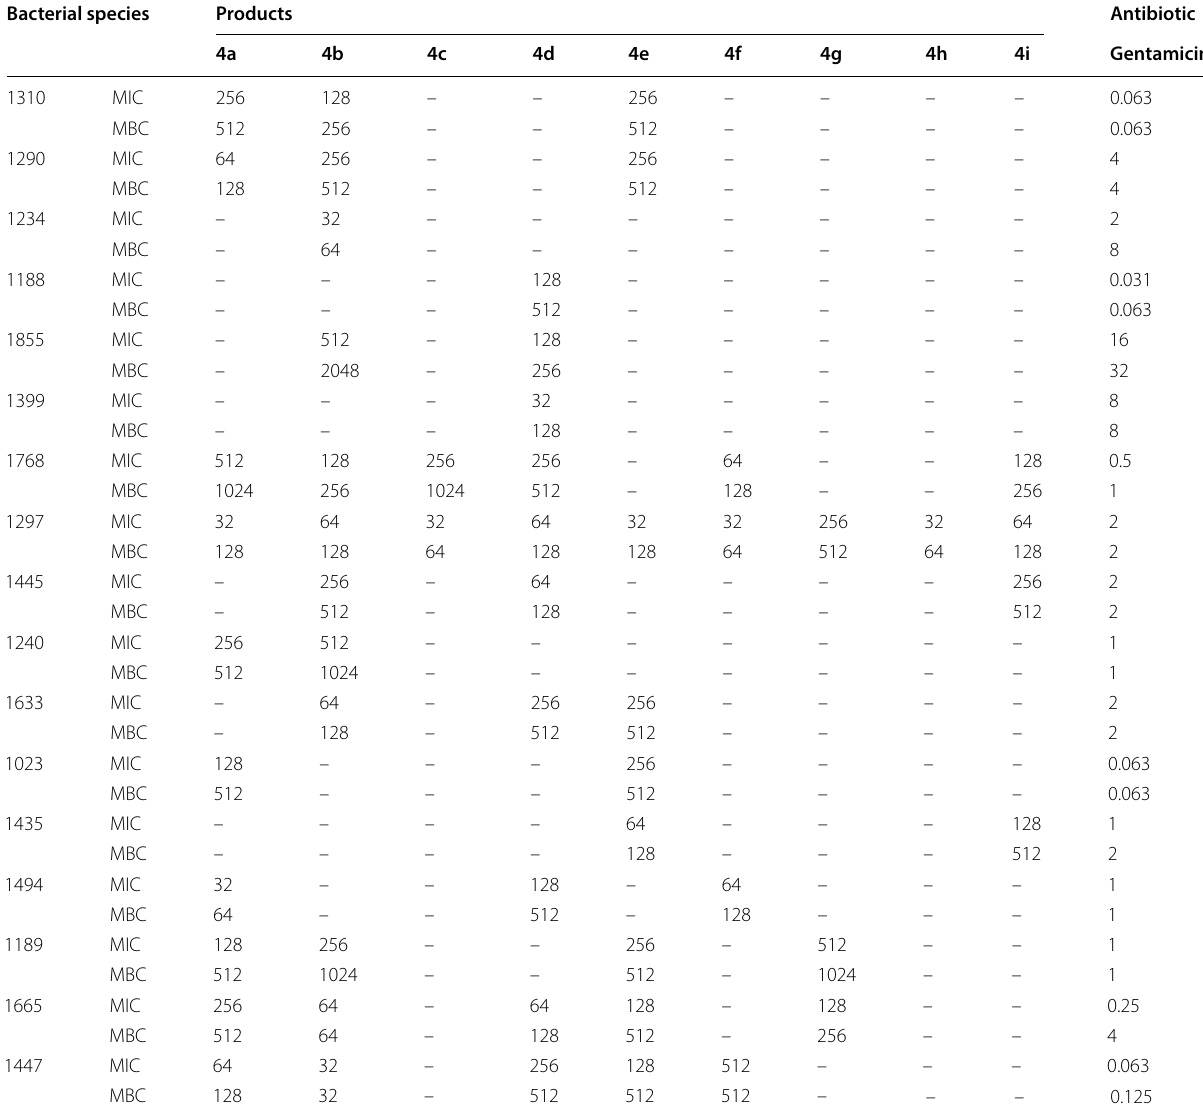
–: No noticeable antibacterial effect at concentration of 10,240 μg ml − 1 , MIC (μg ml − 1 ), MBC (μg ml − 1 )